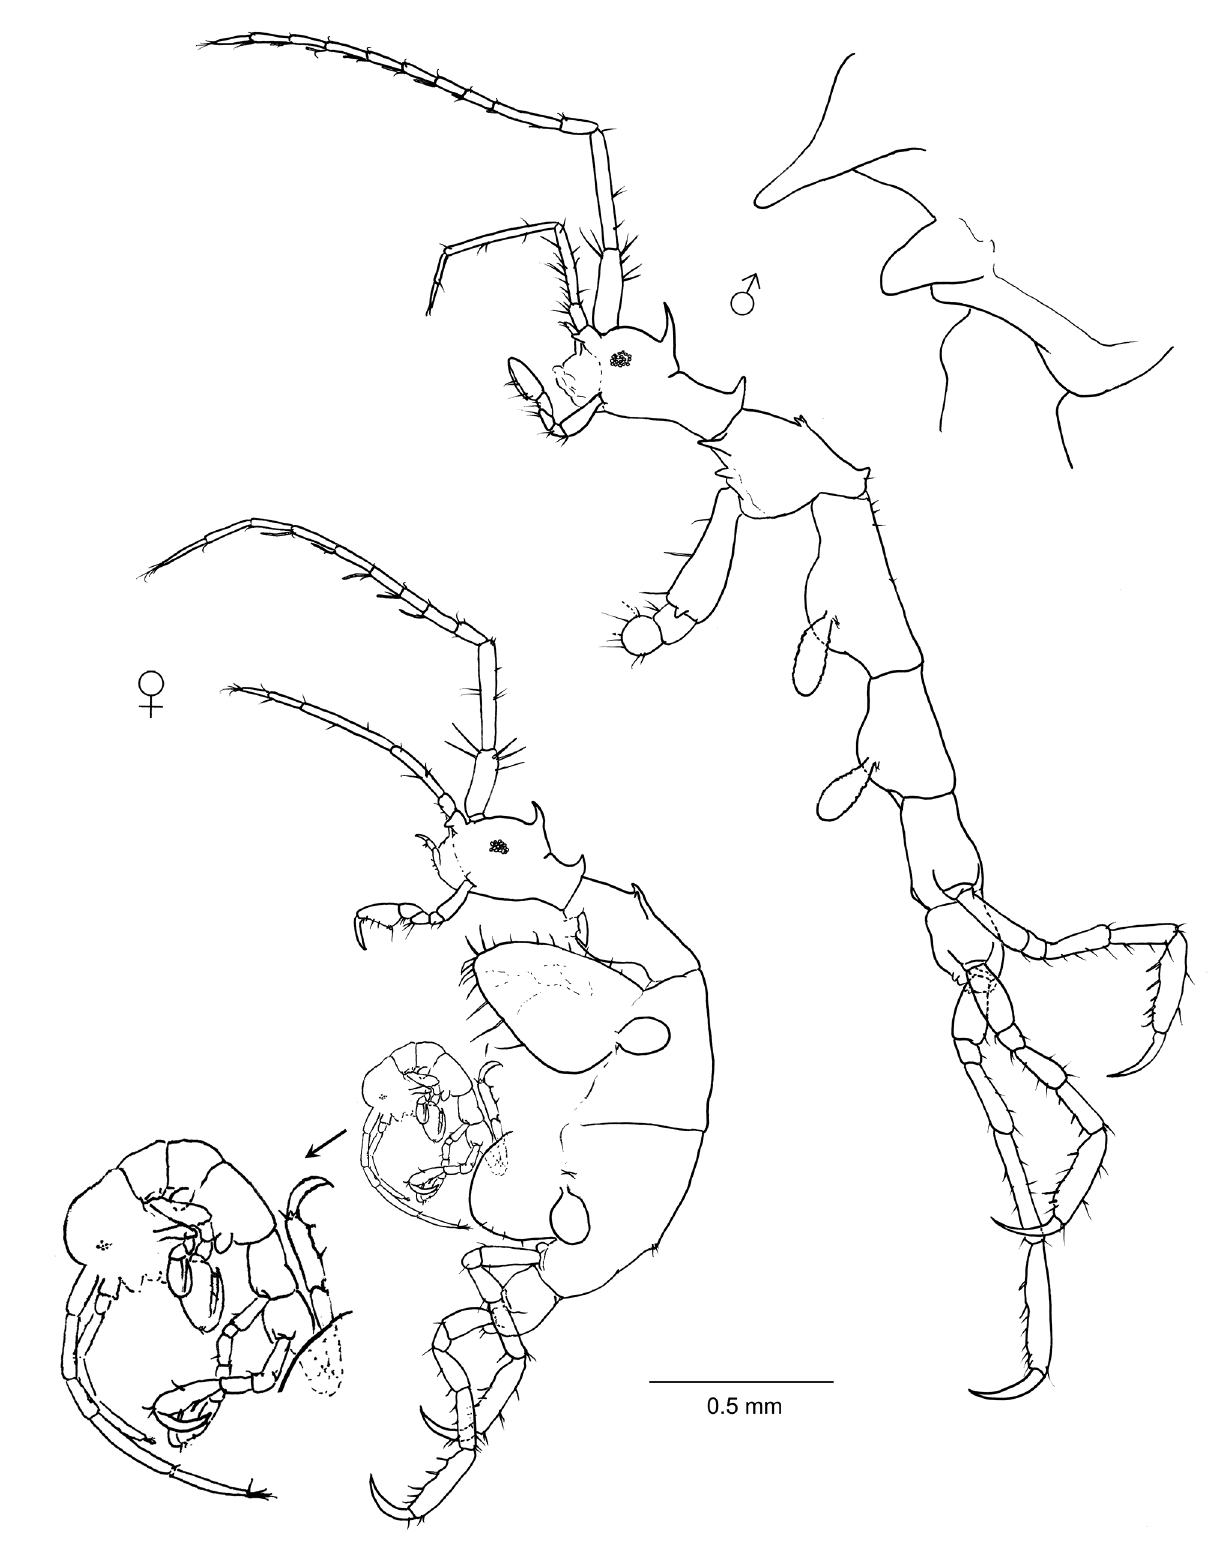
Figure 2 . Parapseudaeginella australiensis n. sp. Lateral view of holotype male (WAM C76110) and paratype female (AM P.101303). Detail of hatchling emerging from the brood pouch